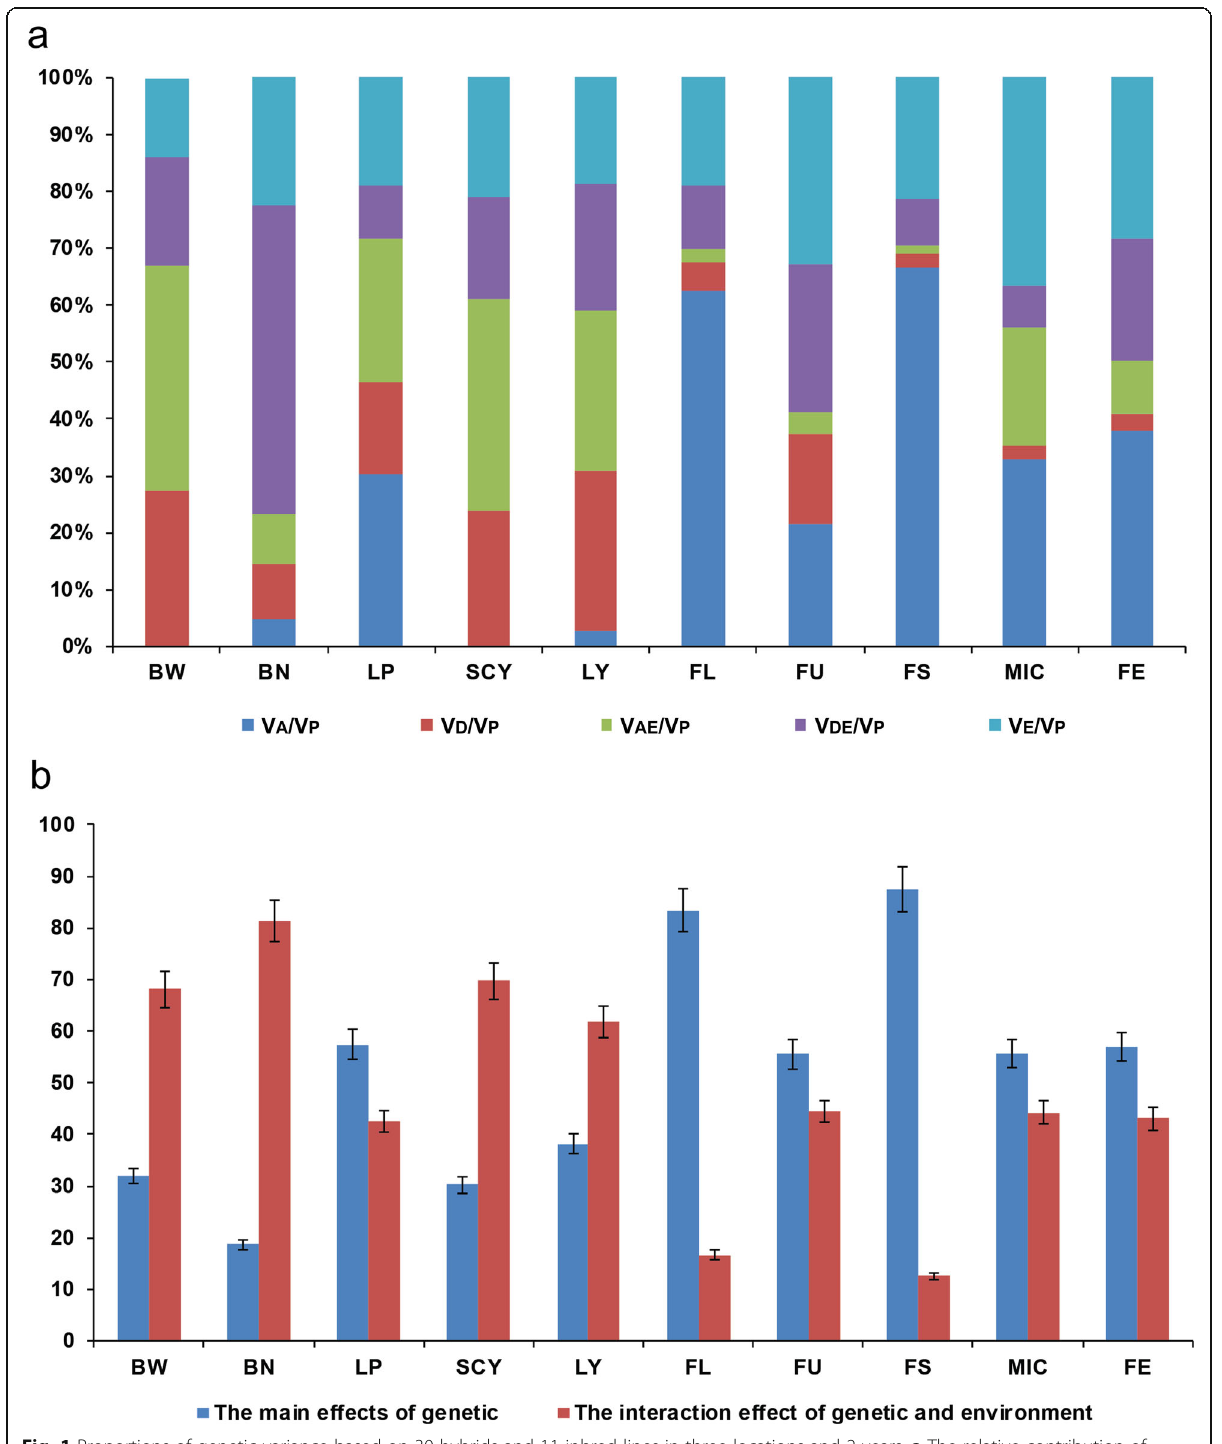
Fig. 1 Proportions of genetic variance based on 30 hybrids and 11 inbred lines in three locations and 2 years. a The relative contribution of genetic components to phenotypic variance. Blue, red, green, purple and cyan colors represent the additive effect, dominant effect, additive- environment interaction effect, dominant-environment interaction effect, and error variance, respectively. b Relative contribution of main genetic effects (additive and dominant effects) and genetic-environment interaction effects to phenotypic variance. Blue and red colors indicate main genetic effects (additive and dominant effects) and genetic-environment interaction effects,